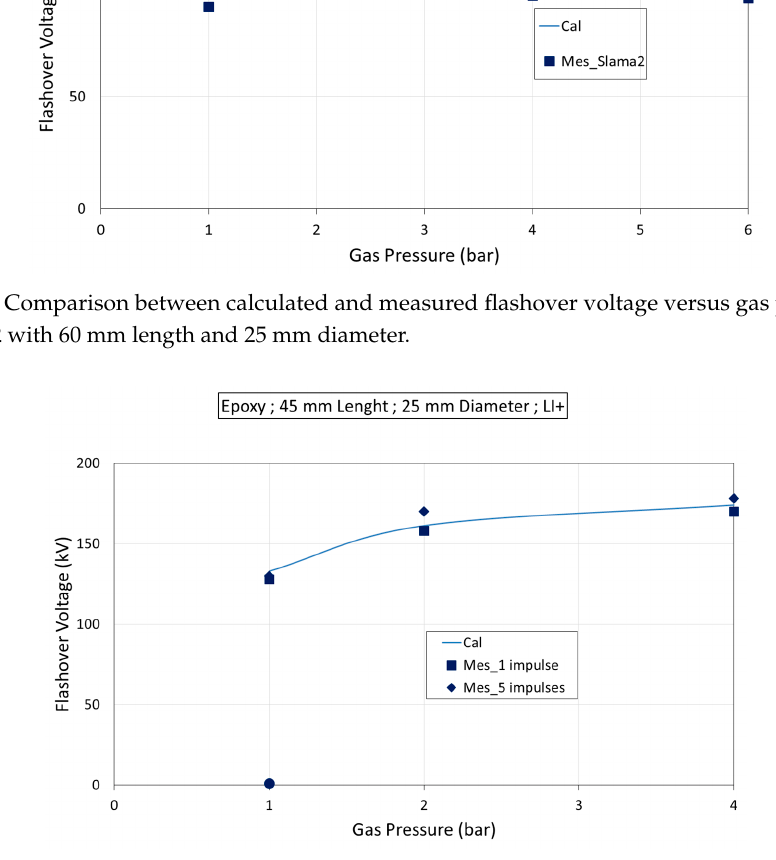
Figure 12. Comparison between calculated and measured flashover voltage versus gas pressure for a cylindrical epoxy insulator 4 with 45 mm length and 25 mm diameter. cylindrical epoxy insulator 4 with 45 mm length and 25 mm